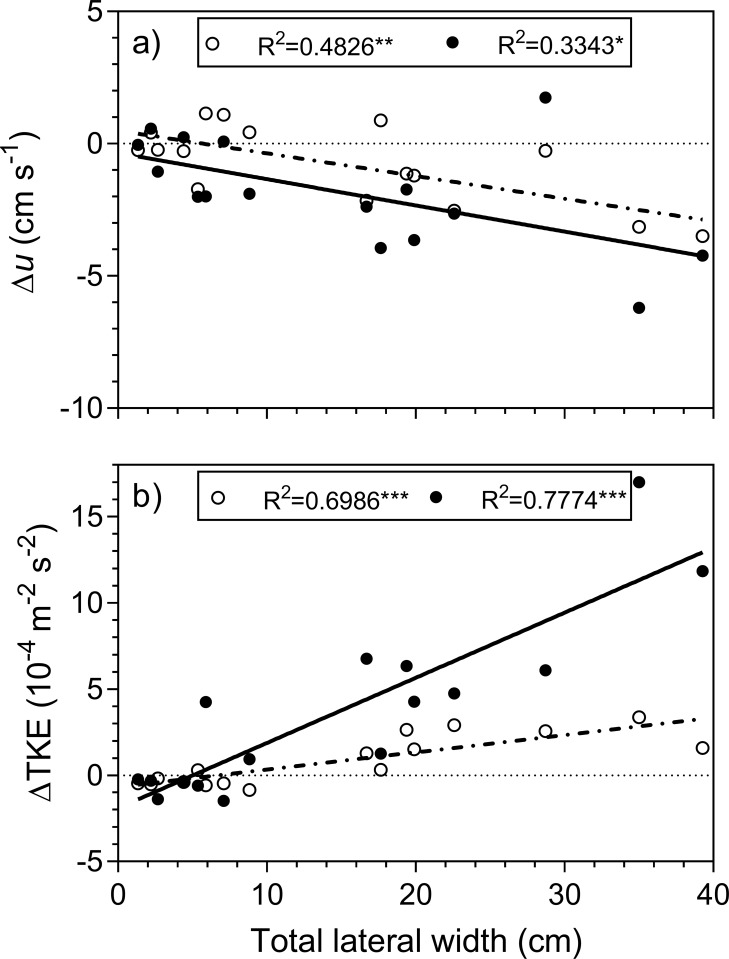
Effects of total width of objects placed within the test section on a) flow velocity, Δu, and b) turbulent kinetic energy, ΔTKE, 1 cm above the sediment. Dashed and solid lines correspond to surface flow velocity of 16 cm s-1 and 30 cm s-1, respectively. Statistically significant is indicated by *p<0.05, **p<0.01, ***p<0.001.